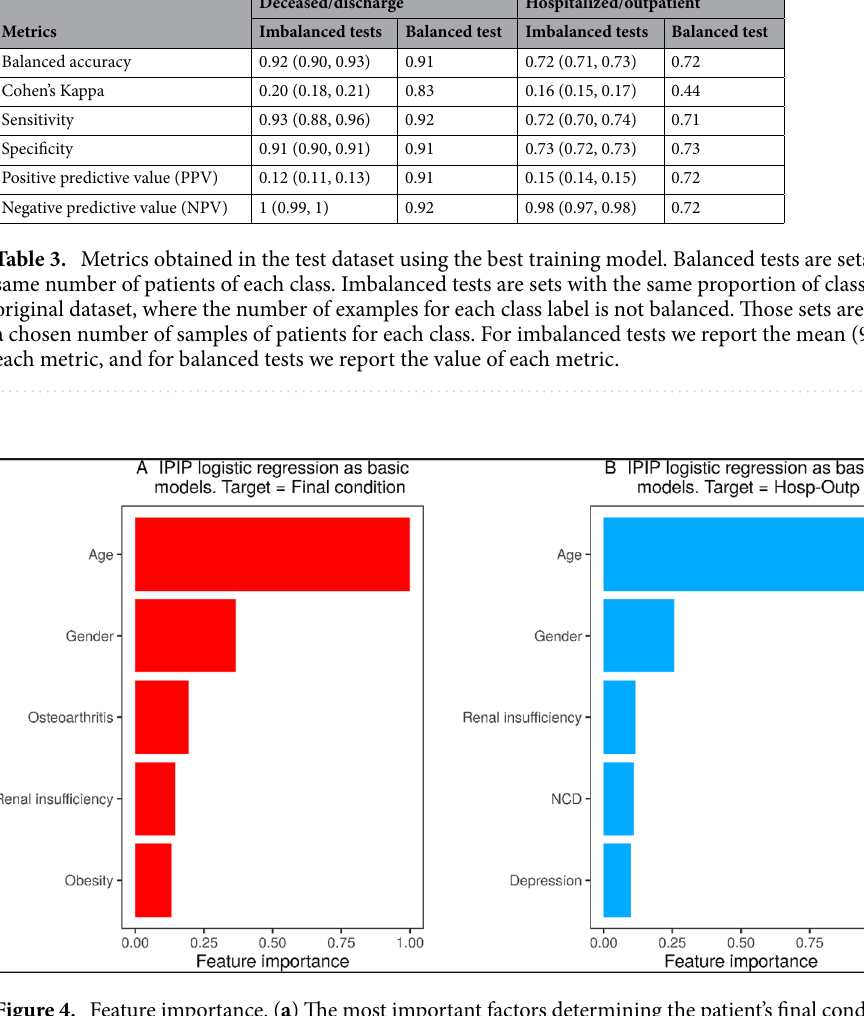
Figure 4. Feature importance. ( a ) The most important factors determining the patient’s final condition (Importance Features) obtained by the LR-IPIP model. ( b ) The most important factors determining the need for hospitalization obtained by the LR-IPIP model. NCD is the number of chronic